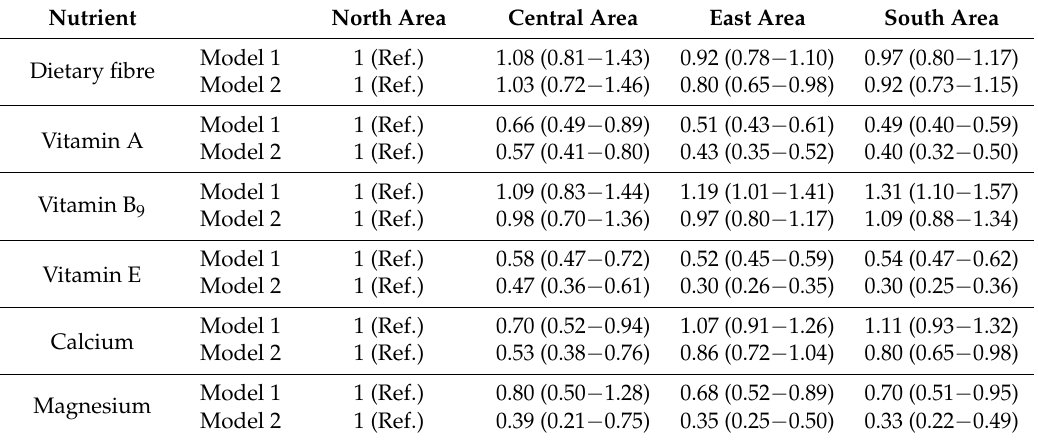
Table 4. Results from the logistic regression model of micronutrient inadequate intakes according to 2/3 DRIs by geographical areas.